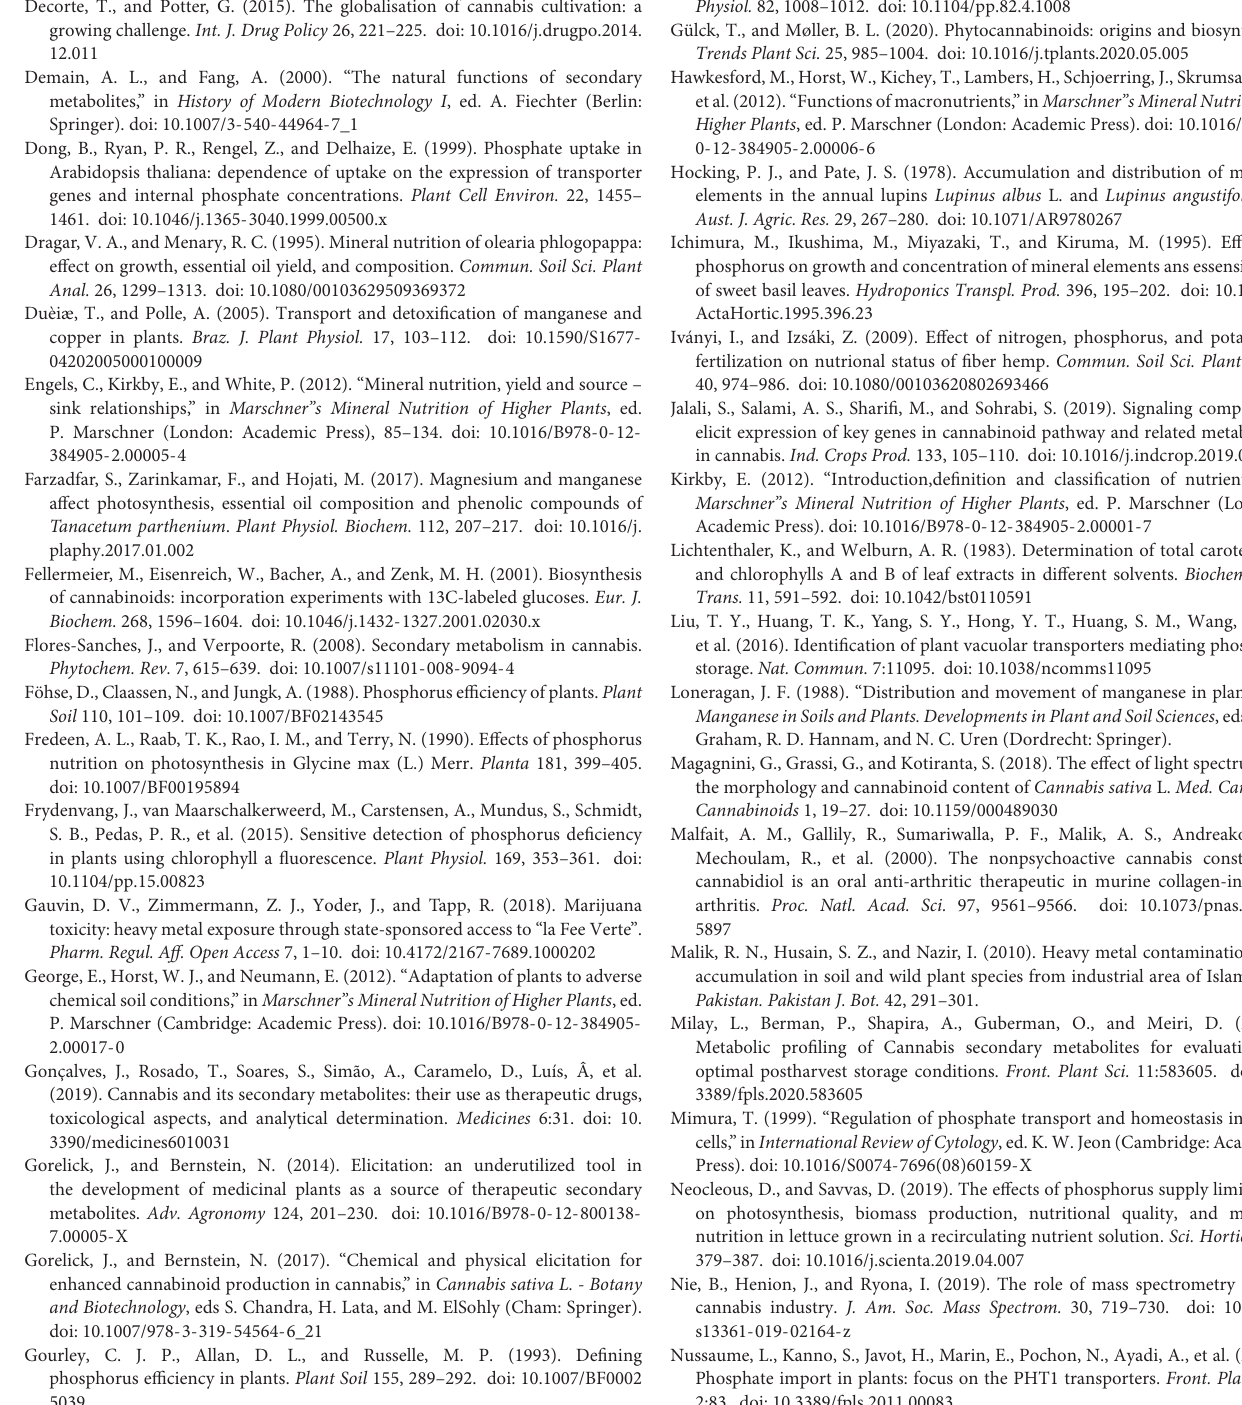
Phosphate import in plants: focus on the PHT1 transporters. Front. Plant Sci. 2:83. doi: 10.3389/fpls.2011.00083